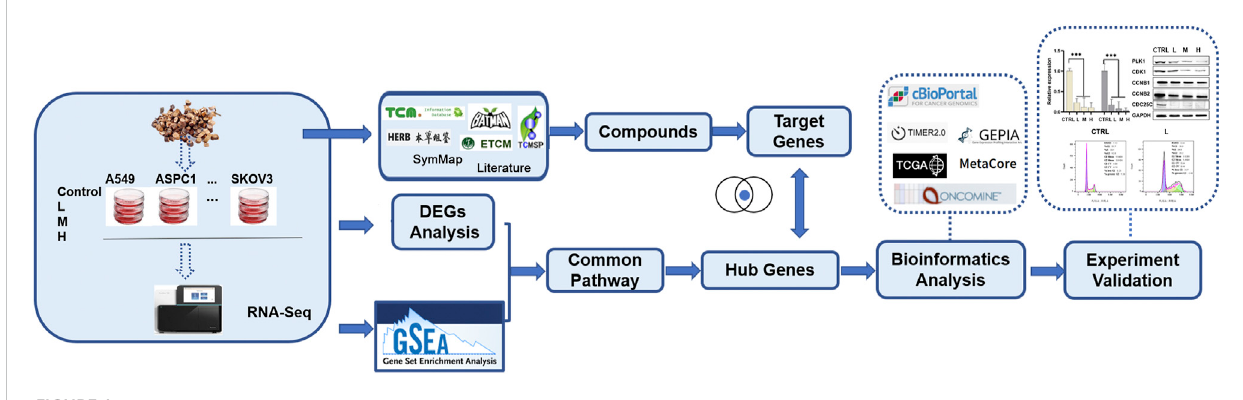
FIGURE 1 General work fl ow and research methods of this study.